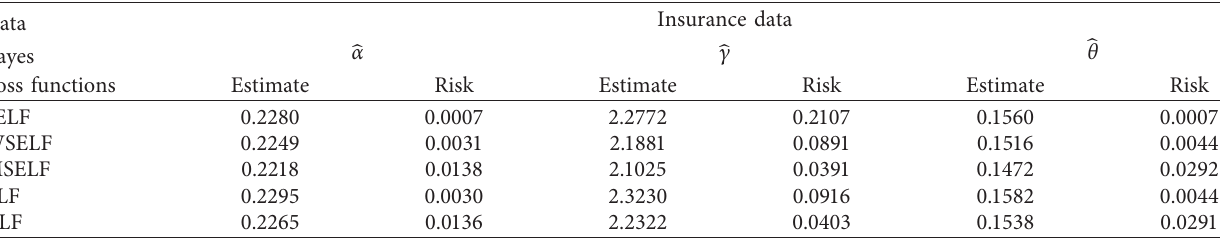
Table 8: Bayesian estimates and their posterior risks of the parameters under different loss functions based on the failure time data.